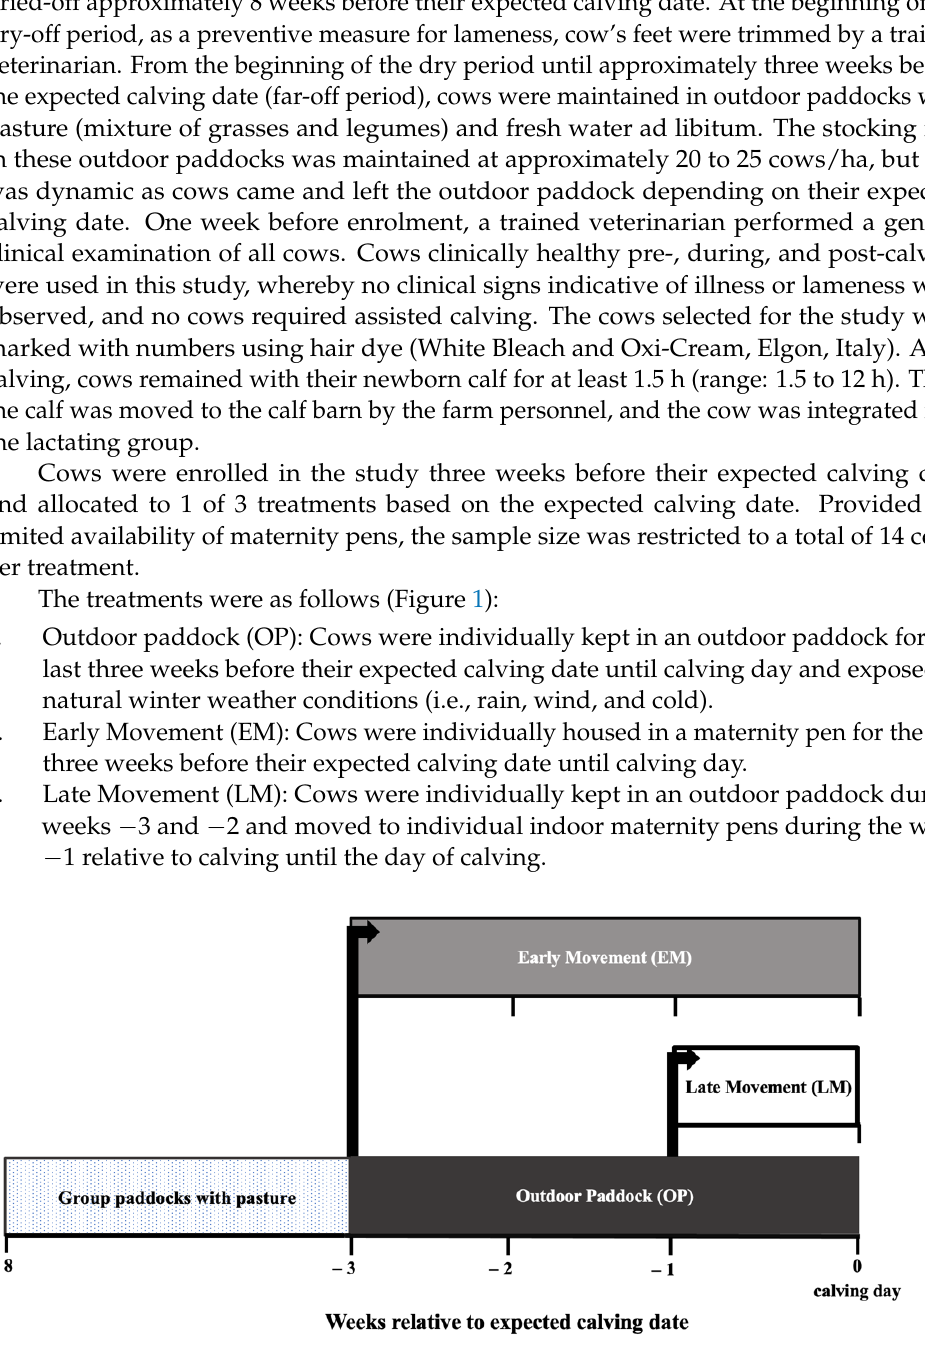
Figure 1. Diagram of the study design. During the far-off period, cows were grouped together in an outdoor paddock with pasture. Three weeks before the expected calving date, cows were individually allocated to 1 of 3 treatments: Outdoor paddock (OP; black bar), where cows were individually kept in an outdoor paddock from 3 weeks before until the day of calving; Early movement (EM; grey bar), where cows were individually housed in a maternity pen from 3 weeks before until the day of calving; and, Late movement (LM; white bar), where cows were individually kept in an outdoor paddock during weeks − 3 and − 2 and moved to individual indoor maternity pens during week − 1 relative to calving until the day of